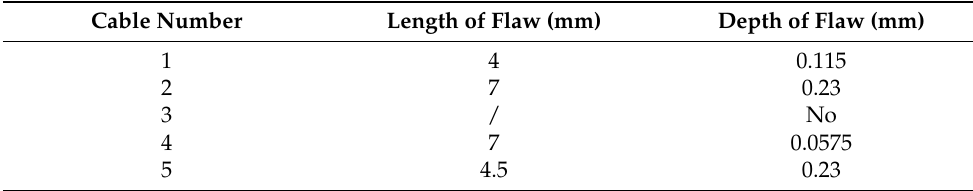
Table 3. Parameters of the defects in the insulation layer of the Group #1